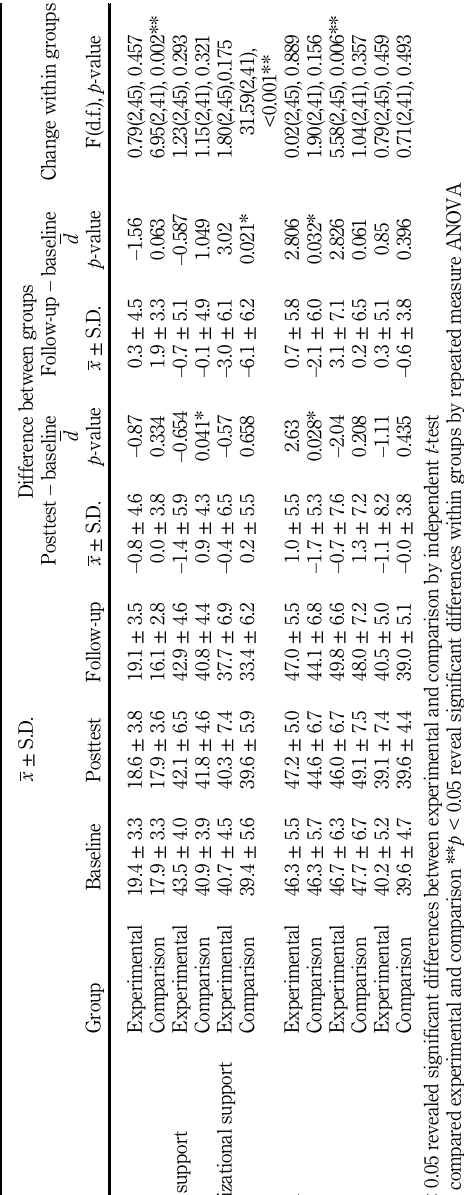
Table 4. Secondary outcomes